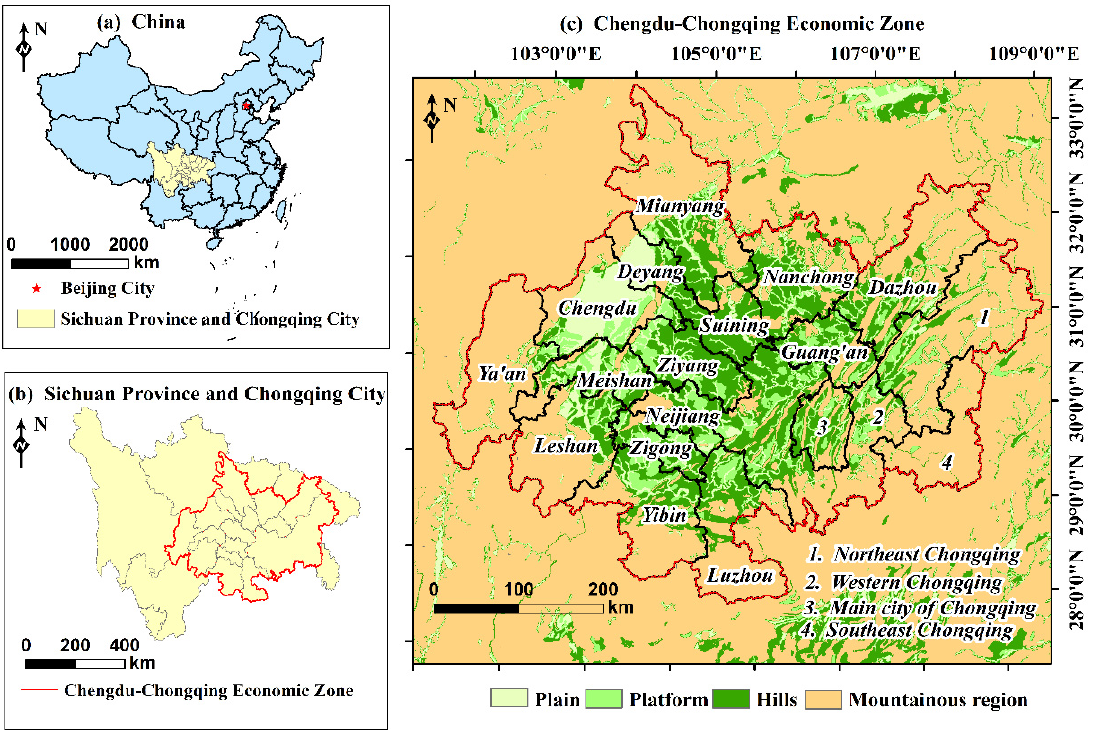
Figure 1. Overview of the study area in 2020. ( a ) The location of Sichuan and Chongqing in China; ( b ) Location of the Chengdu-Chongqing Economic Zone in Sichuan and Chongqing; ( c ) Topography characteristics and scope of the Chengdu-Chongqing Economic Zone. The Chengdu-Chongqing Economic Zone includes 15 cities in the Sichuan Province and 31 districts and counties in Chongqing.